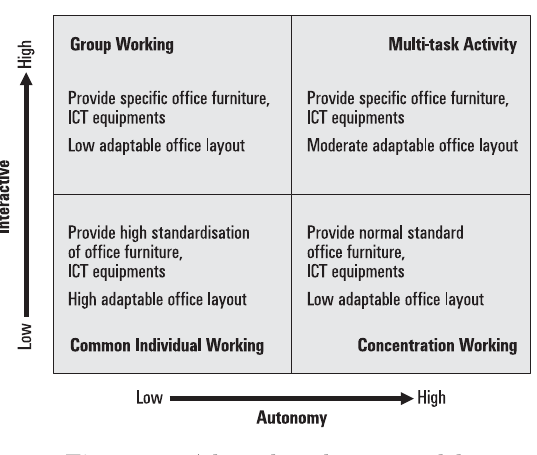
Figure 11. Adapted workspace model for workspace